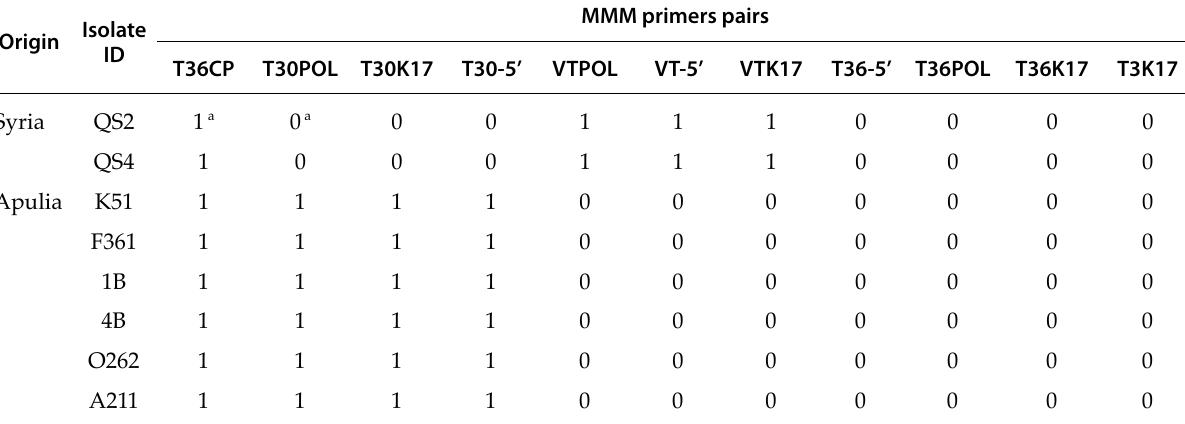
Table 1. Results obtained after amplification using specific primers in selected Citrus tristeza virus isolates with the multiple molecular markers (MMM).